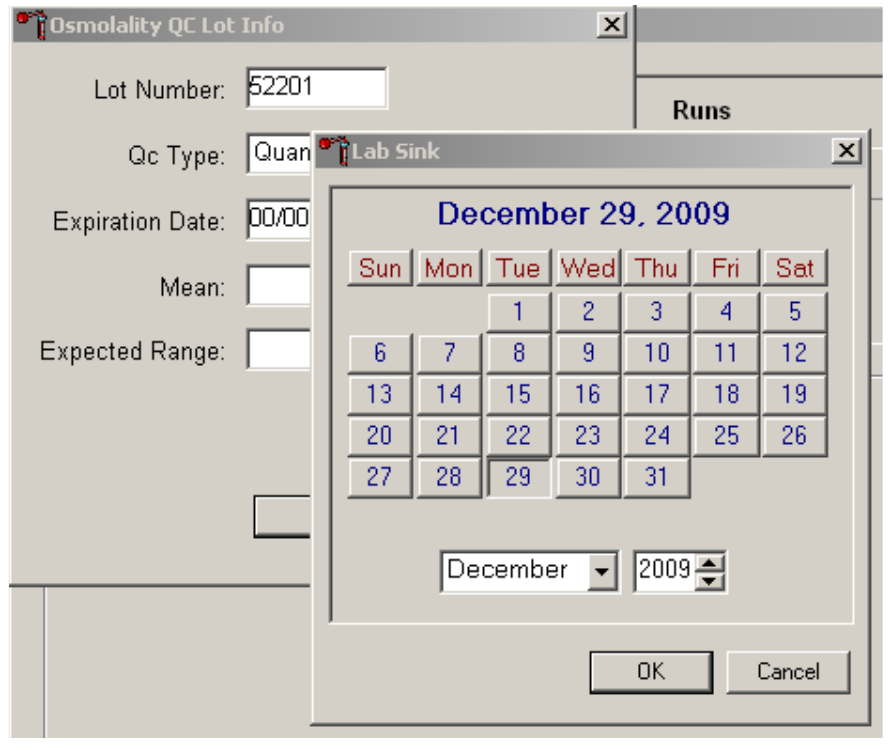
Use the up and down arrow buttons to scroll to the correct year of the expiration date. Use the drop-down list to select the correct